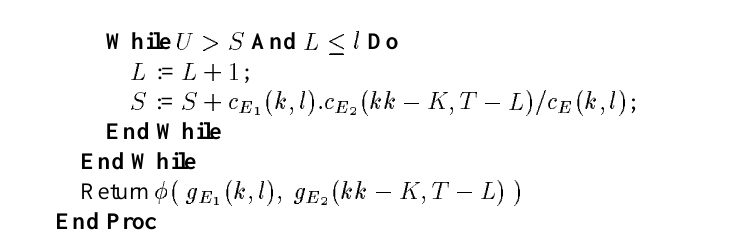
Fig. 6: A random generation